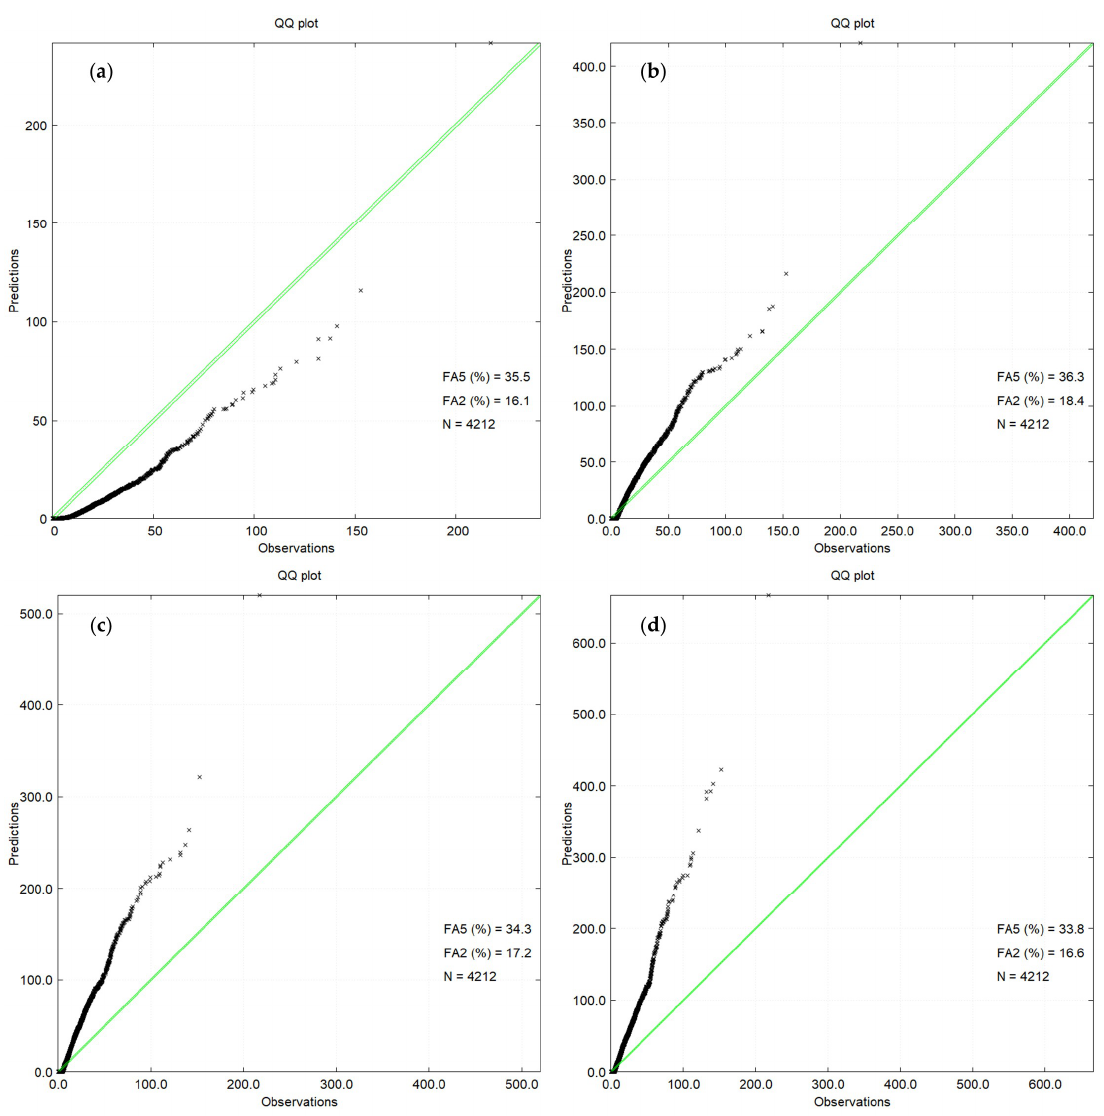
Figure 9. QQ plot of ( a ) AERMOD, ( b ) LAPMOD WT, ( c ) LAPMOD JJ + RS and ( d ) LAPMOD JJ + JJ for 24-h concentrations of Kincaid SO 2 (μg m −3 ).